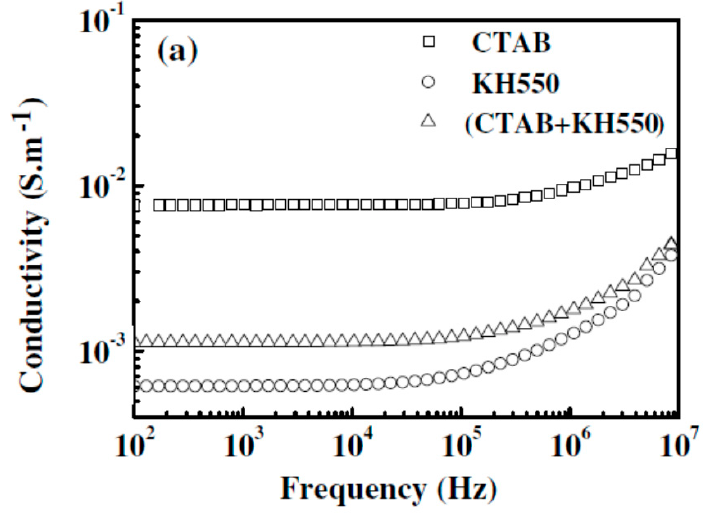
Figure 20. Variation of conductivity with frequency for MWCNTs/VMQ composites (1.6 vol% MWCNTs loading) with different modifiers at room temperature [10].